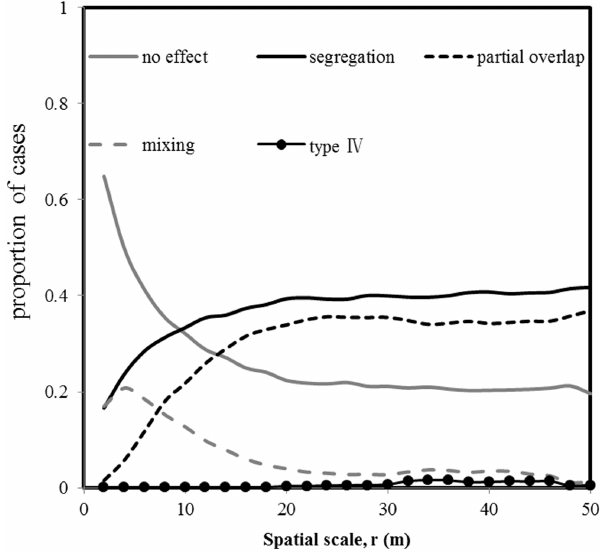
Figure 2. Overall interspecific association patterns in depen- dence on the scale